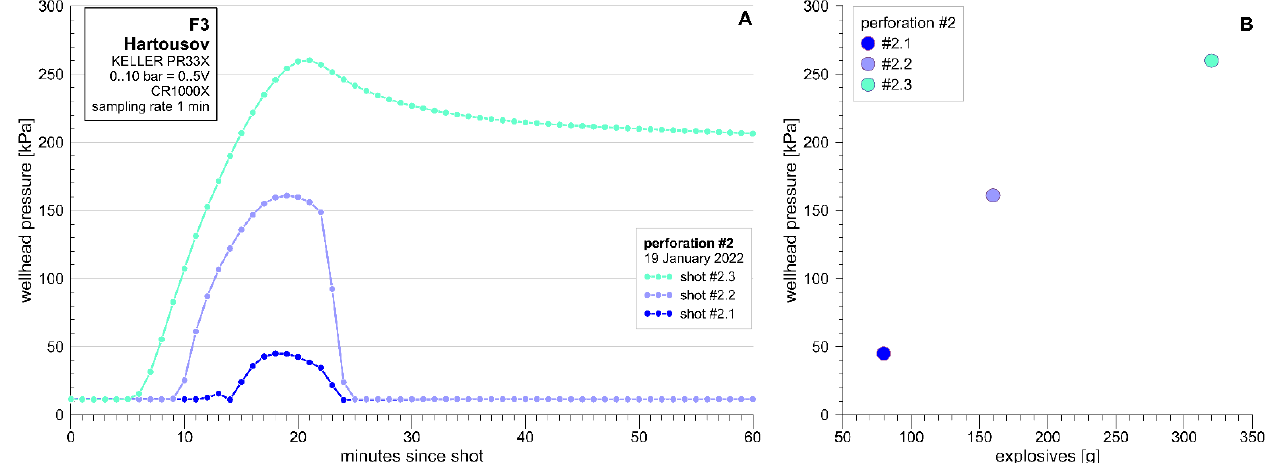
Figure 10. Wellhead pressure changes following three perforation shots on 19 January 2022. ( A ) Temporal evolution, ( B ) pressure increase related to the amount of explosives.